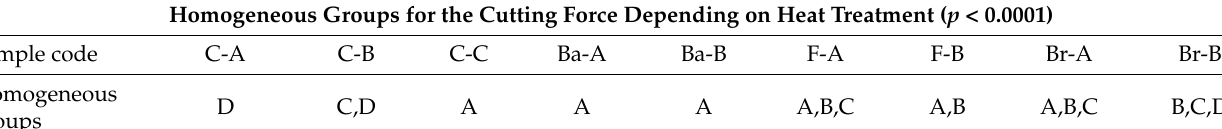
Table 8. Statistical analysis of texture of chicken breast fillet